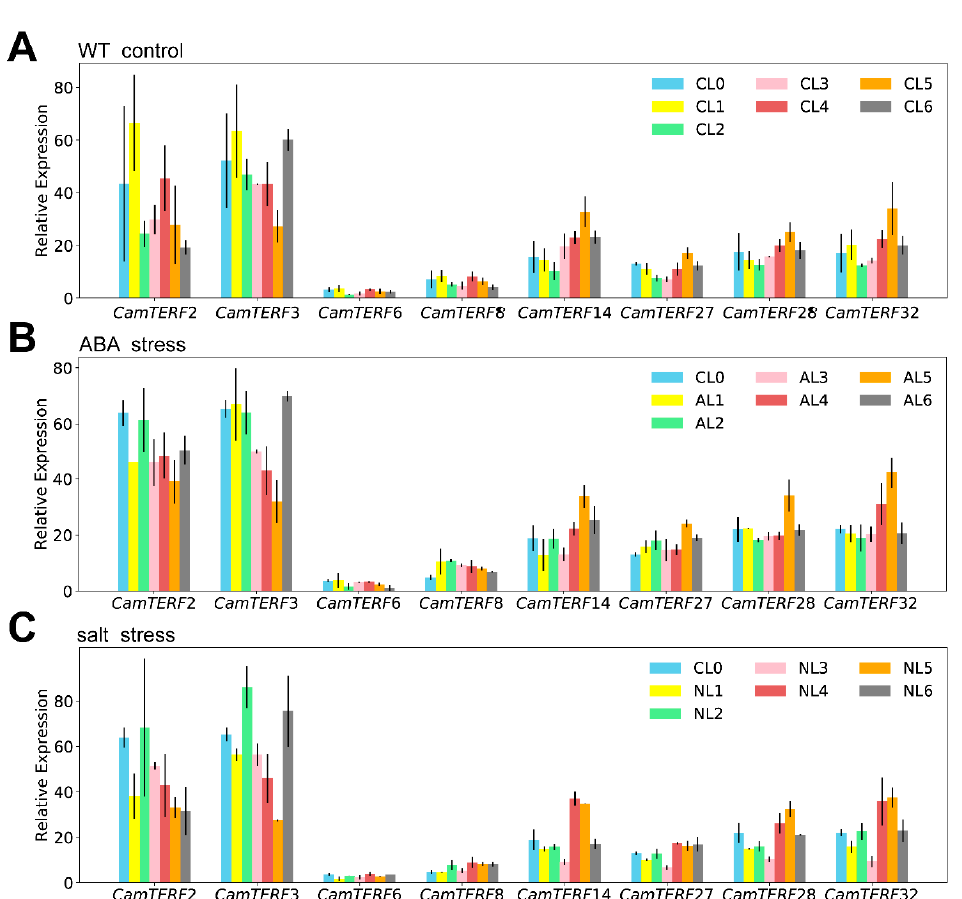
Figure 7. ( A ) Expression profiles of CamTERFs untreated following a 24 h time course; ( B ) expression profiles of CamTERFs under ABA (Abscisic acid) stress following a 24 h time course; ( C ) expression profiles of CamTERFs under salt stress and following a 24 h time course.